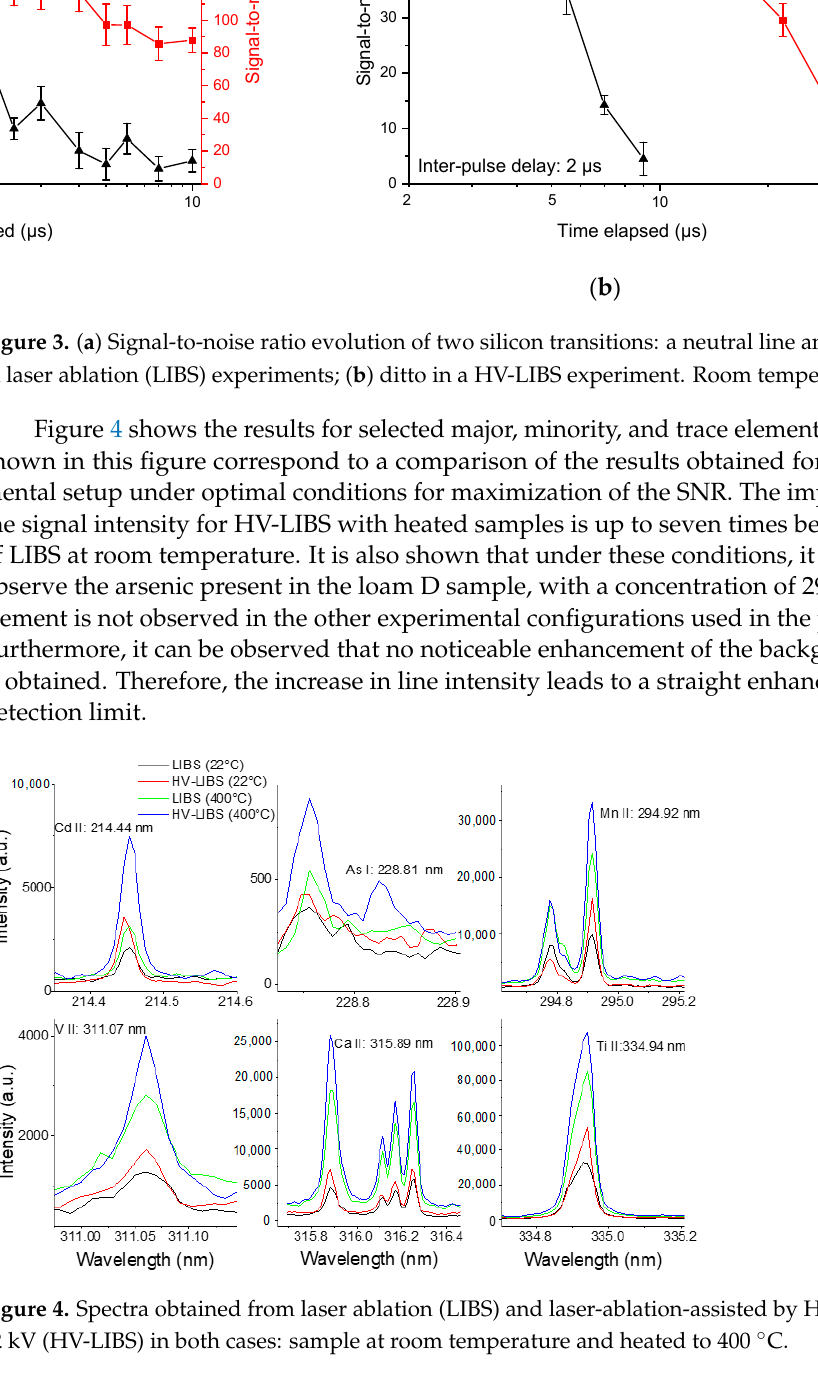
Figure 4. Spectra obtained from laser ablation (LIBS) and laser-ablation-assisted by HV discharge at 12 kV (HV-LIBS) in both cases: sample at room temperature and heated to 400 ◦ C. Subsequently, 100 individual spectra were acquired at ten spots under the different conditions used. The results were averaged to obtain the SNR and the detection limits. For each element, lines that had no spectral interference and maximized the sensitivity of trace detection were chosen.